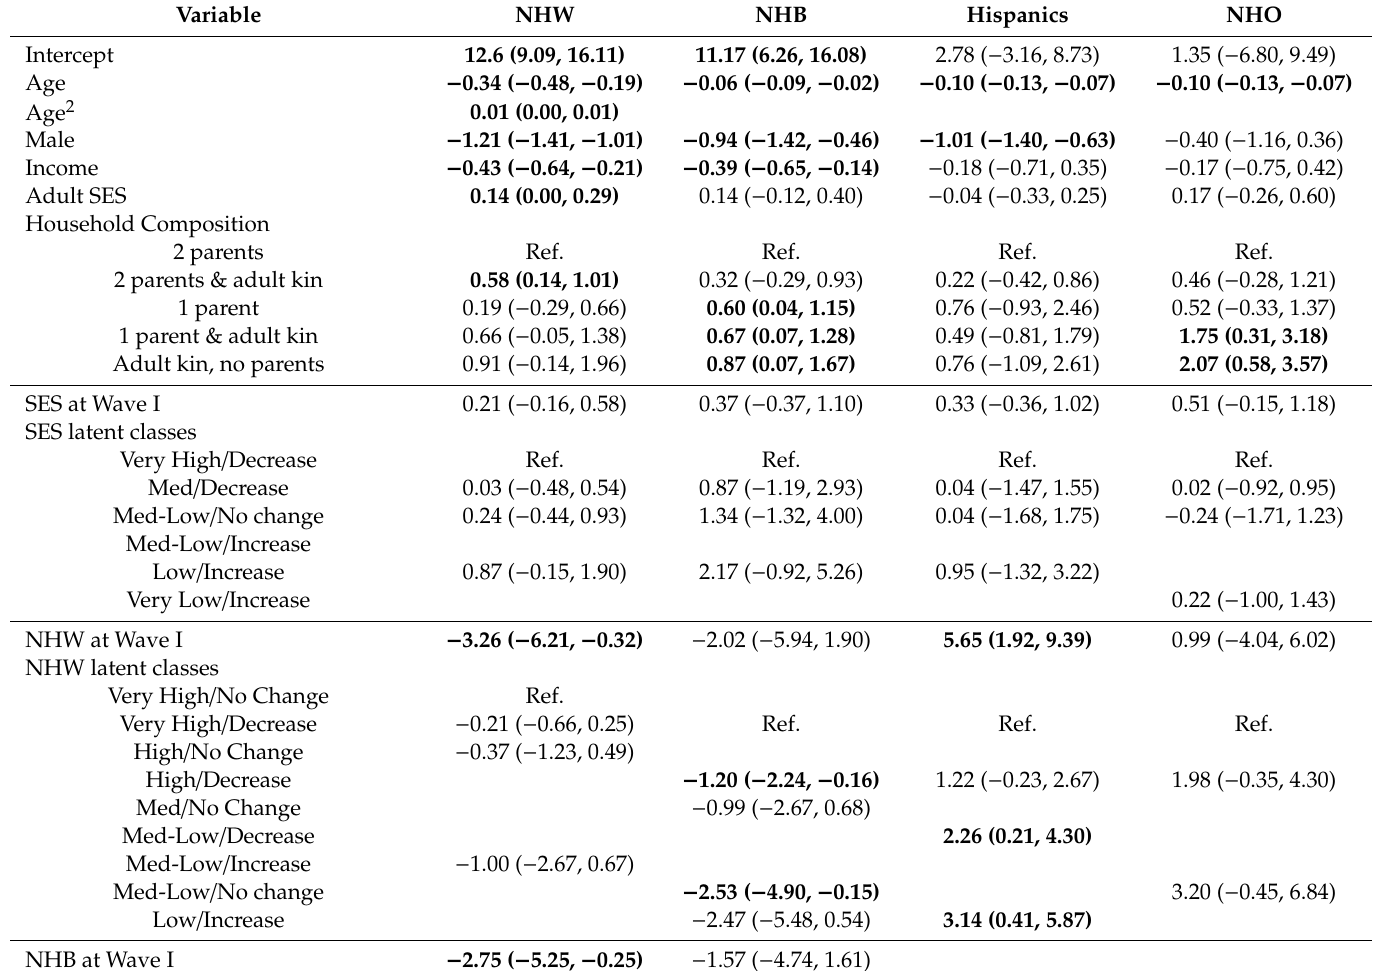
Table 2. Results of multi-level growth curve models of depressive symptoms (Betas and 95% Confidence